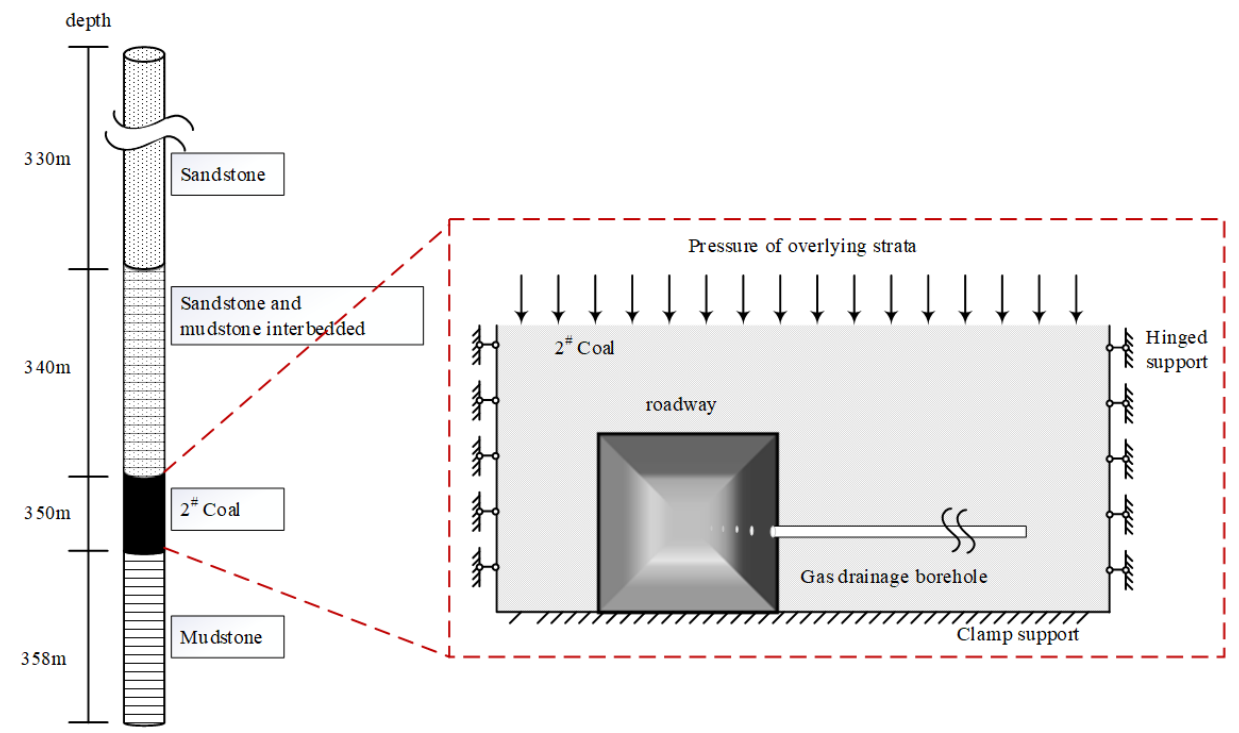
Figure 1. Mechanical model of the borehole and roadway intersection. (2# represents the second layer of coal which is a sample differentiation symbol to indicate different coal seams.)